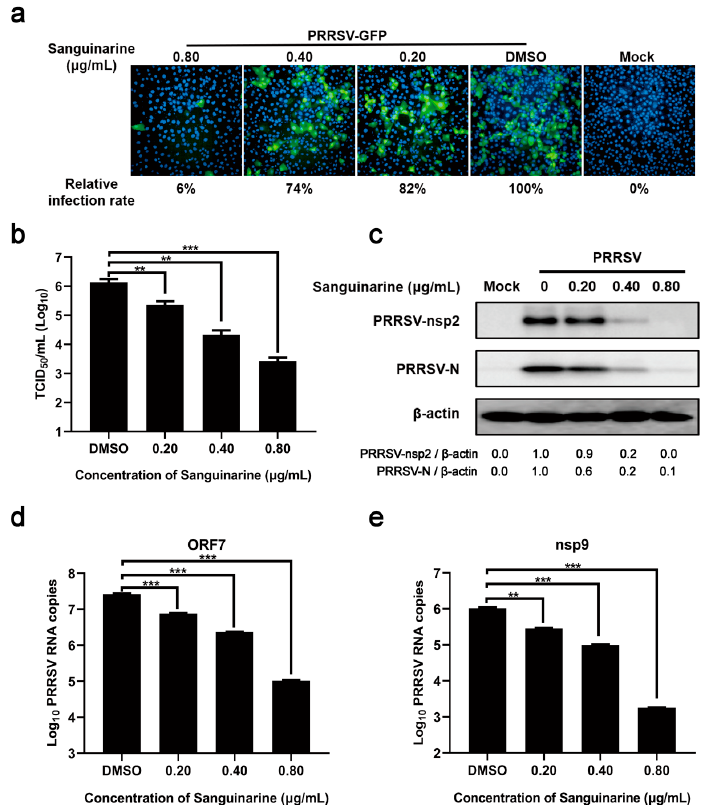
Figure 3. Sanguinarine inhibits the propagation of PRRSV in a dose-dependent manner. MARC-145 cells were incubated with sanguinarine (0.20, 0.40, and 0.80 µ g/mL) and PRRSV/PRRSV-GFP (MOI = 0.5) for 24 h as described in 2.9 of the Section 2. The group treated with DMSO was set as a negative control. Then, the infection rate, viral titers, protein levels of PRRSV N/nsp2, and mRNA levels of PRRSV ORF7/nsp9 were evaluated by immunofluorescence assay ( a ), TCID 50 assay ( b ), Western blot assay ( c ), and RT-qPCR ( d , e ), respectively. ( a ) The infection rate was averaged from nine visual fields. The infection rate of DMSO-treated group was set as 100%. ( c ) The ratios of nsp2/ β -actin and N/ β -actin were analyzed using ImageJ. ( b , d , e ) Data are expressed as the means and standard deviations from three independent experiments and analyzed using one-way ANOVA. **, 0.001 ≤ p < 0.01; ***, p < 0.001.